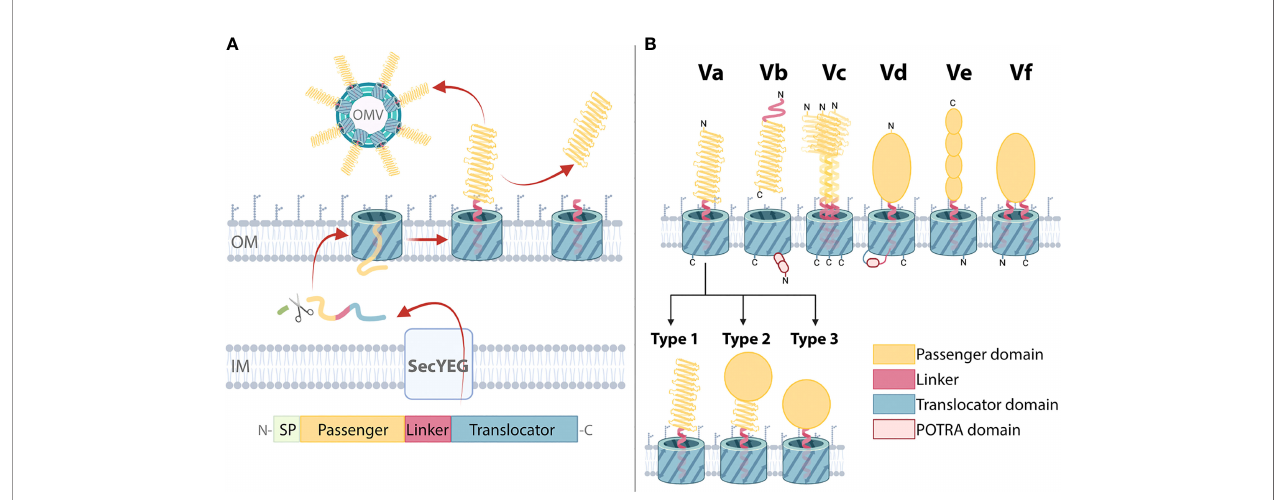
FIGURE 1 | Biogenesis and domain architecture of the type 5 secretion system (T5SS). (A) AT secretion mechanism modelled on classical ATs with the following domain organization: The N-terminal signal peptide (SP) is followed by the passenger, linker, and translocator. The SP targets the ATs for inner membrane (IM) secretion via the SecYEG translocon which is subsequently cleaved by a periplasmic peptidase. The translocator inserts into the outer membrane (OM), forming a b -barrel with the a -helical linker spanning its pore. The passenger is translocated to the OM surface where it folds into its tertiary structure. In some ATs, the passenger is cleaved and secreted into the external milieu. Release can also occur through outer membrane vesicles (OMVs). (B) T5SS subtypes Va-Vf. Three basic domains (the passenger, linker, and translocator) are present in all T5SS subtypes with variations in topology, domain order, and oligomeric states producing six different subtypes (16 – 18). These